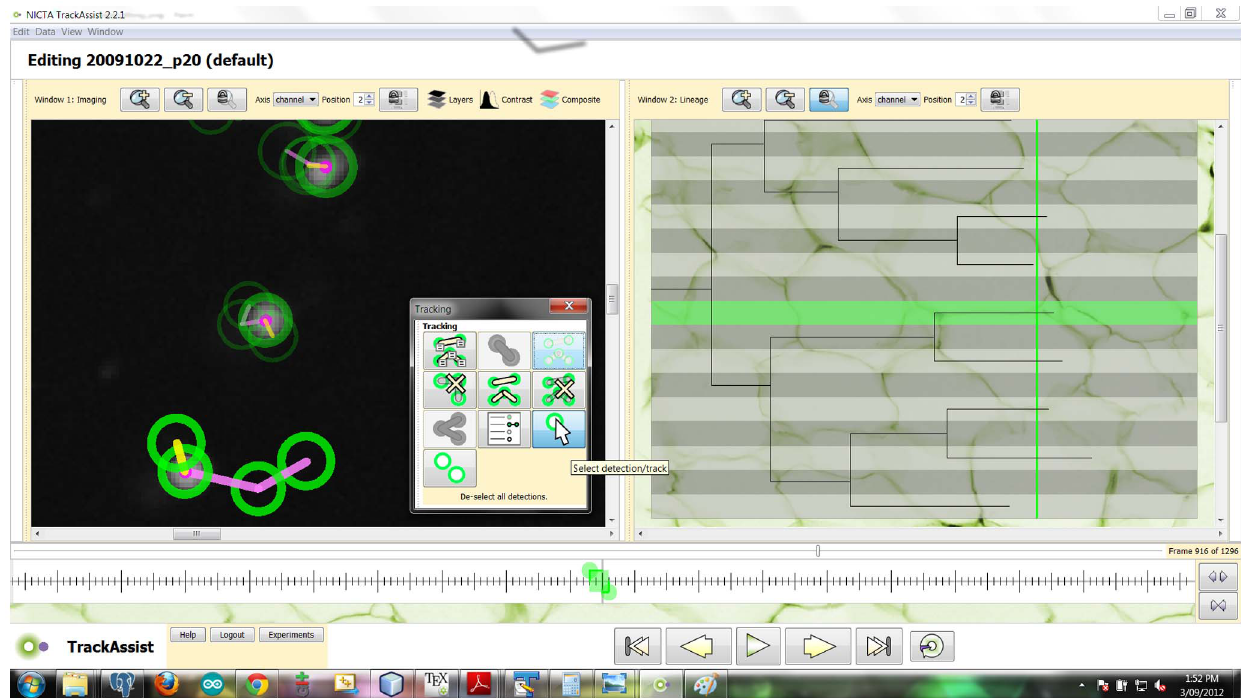
Figure 11. Graphical user interface of the TrackAssist software. This figure shows one imaging window on the left (many can be shown at once) and one lineage window (right). The lineage window has a vertical green line indicating the currently viewed time point and a thick horizontal green bar indicating a single selected track. The selected track is visible on in the imaging window. Tracks are currently shown as a ‘‘window’’ of 4 detections, 1 future (yellow), and 3 past (purple). The current detection has a dot in the centre. Green circles indicate the size of each detection. The past and future time window is controlled by moving the green circles in the time control (bottom). The tracking tools are also visible. In row-major order from top left, these are: Annotated tracking; associate tracks & detections; de-select all tracks & detections; delete selected track; automatic tracking; delete all tracks; fork tracks; tracking legend; select tracks & detections; separate selected tracks & detections.